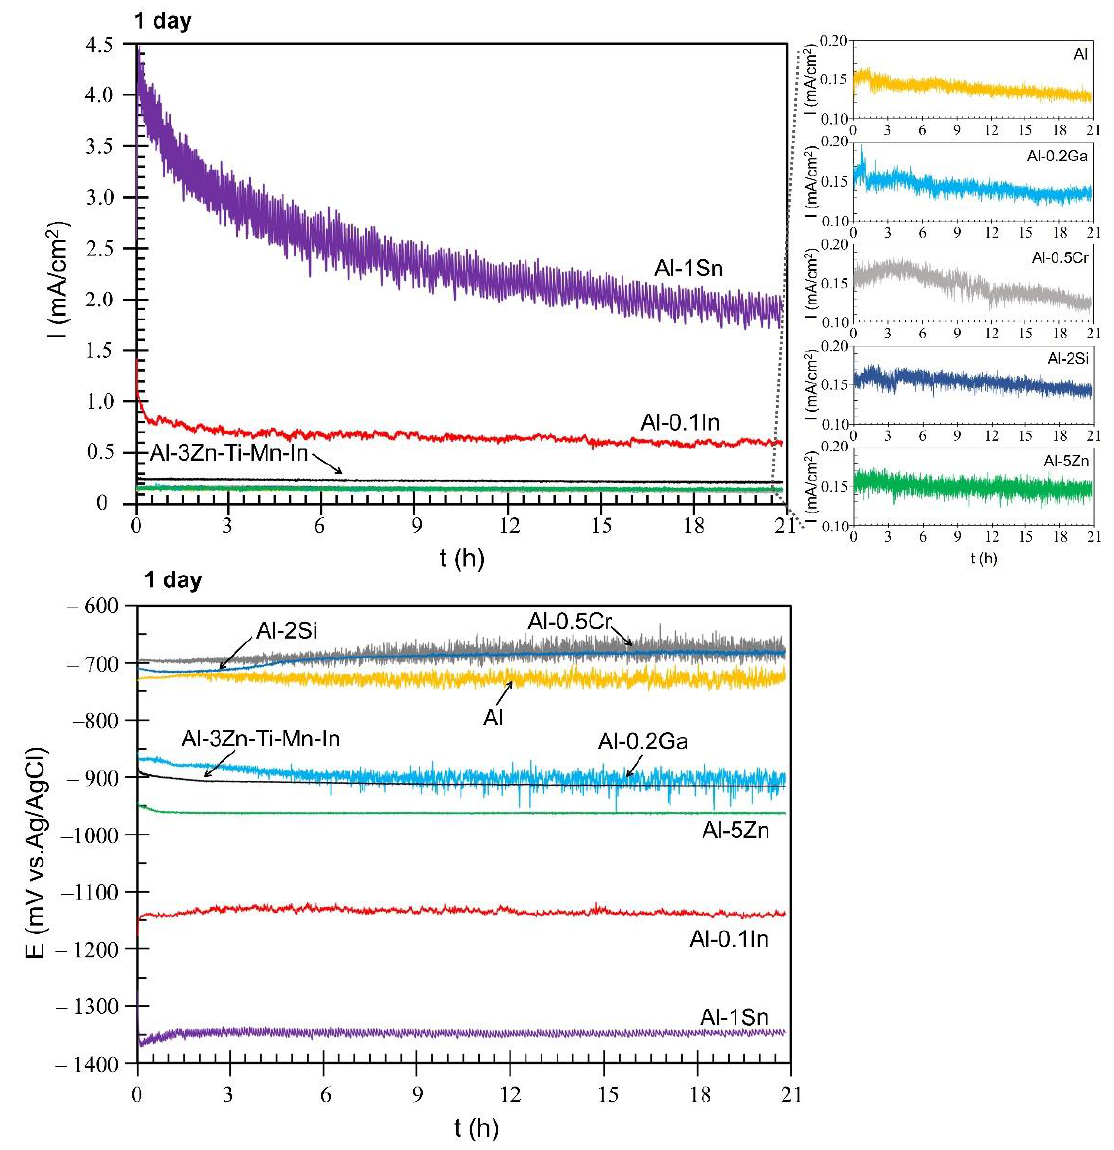
Figure 7. Galvanic current (I) and mixed potential (E) of the galvanic couple: mild steel and solution- treated Al-based alloys after 1 day.